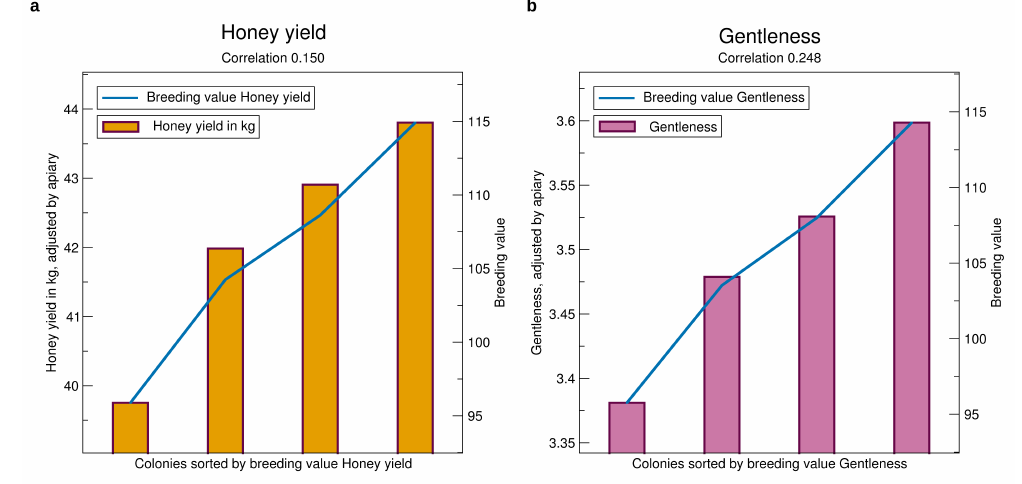
Figure 4. Comparison of prospective breeding values of queens tested in a year, iterated from 2014 to 2019, to the phenotypes standardized to an average apiary, see Section 2.3. The bars represent the adjusted average performance for the colonies, split into four sets by sorted breeding values, quantified by the y-axis to the right. The blue line represents the average breeding values quantified to the y-axis to the left. The x-axis refers to colonies sorted by breeding values. Thus, the breeding values (blue line) are displayed as a line—although for clarity the average for each of the classes is shown. ( a ) Honey yield, ( b ) Gentleness. Significances of all correlations are p < 10 − 16 . The standard errors are about 10 kg for honey yield and 0.4 for gentleness. They are not displayed to avoid compression of the